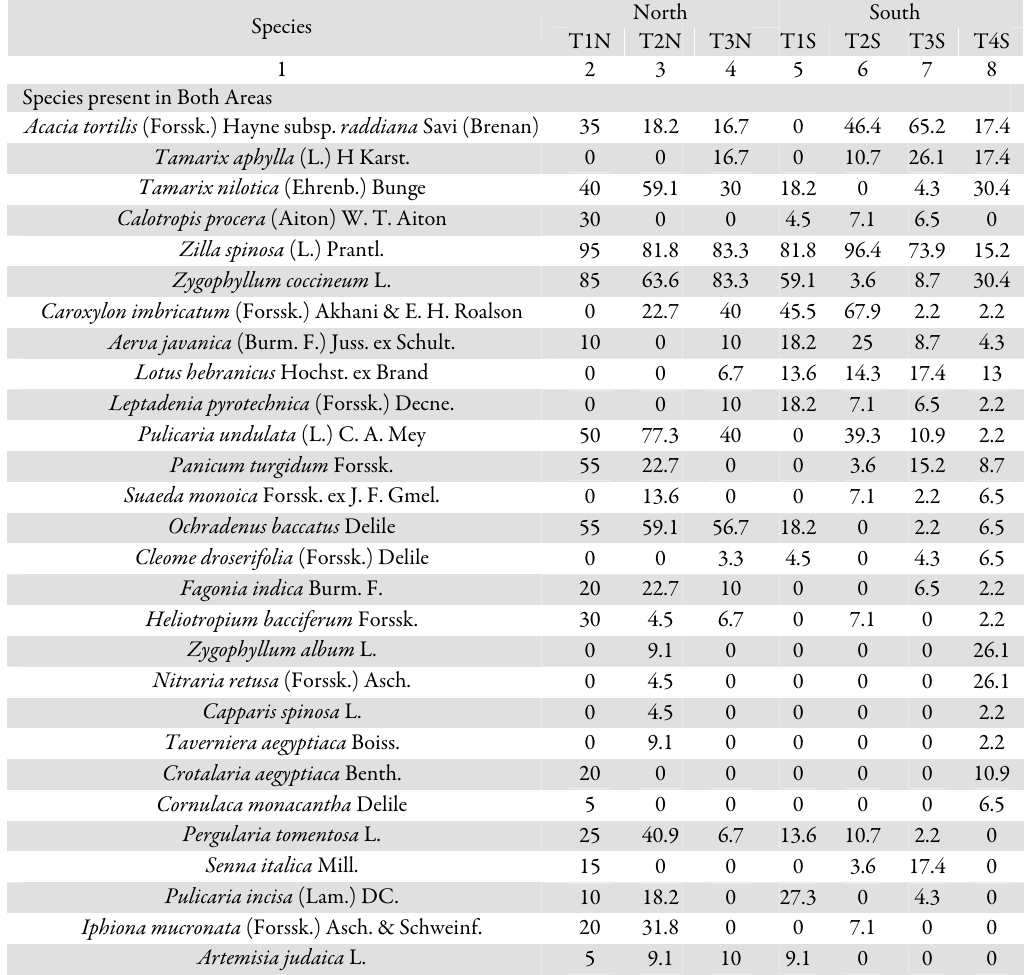
Species present in Both Areas Acacia tortilis (Forssk.) Hayne subsp. raddiana Savi